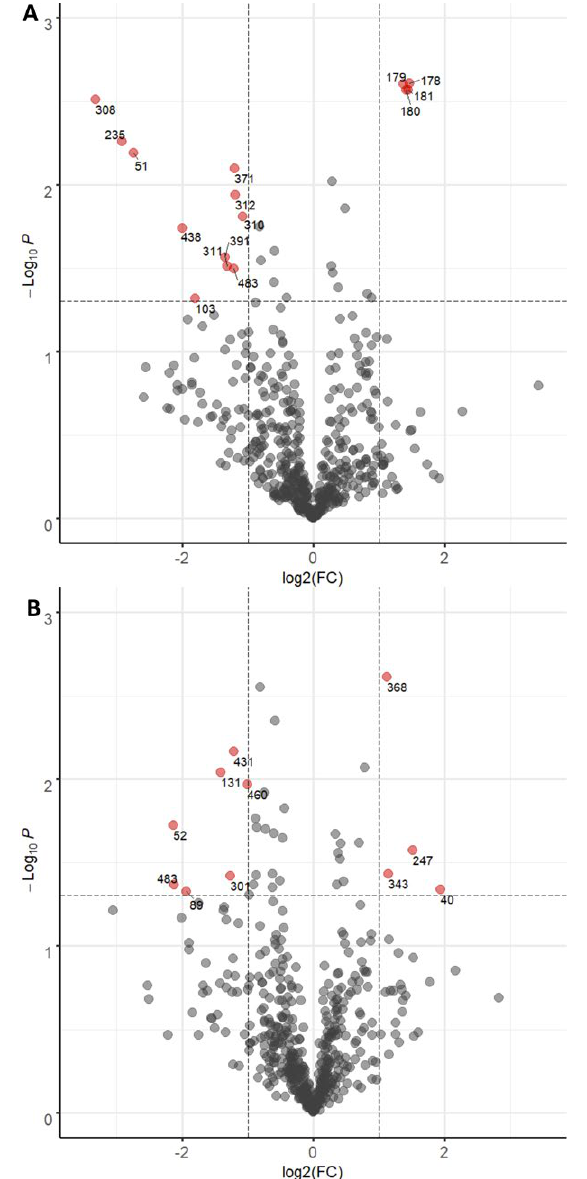
Figure 3. For each metabolite, fold change (C/D) and Student’s T test p-value were calculated between C (control) and D (diseased) samples. The results are displayed on a Volcano plot, with P < 0.05 and FC > 2 thresholds. Each metabolite is displayed by a symbol, in red for P < 0.05, FC > 2, or in grey for P > 0.05, FC > 2. Only metabolites that had fold differences < 12 are displayed. Metabo- lites that were significant and validated the fold change threshold (red symbols) are annotated with their ID numbers. The panels are organized as A) clone 76 C versus D+, B) clone 95 C versus D+.